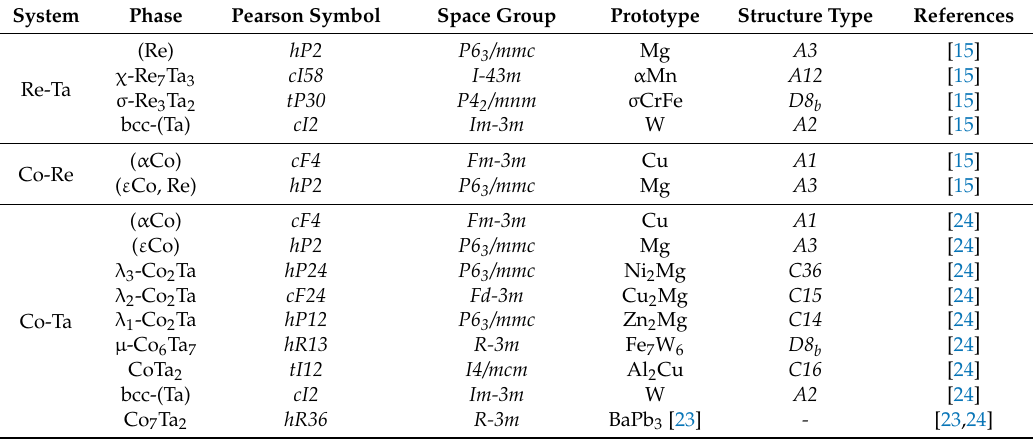
Figure 1. Binary phase diagrams constituting the Co-Re-Ta ternary system [15,24]. Table 1. Crystal structures of each phase in the Co-Re-Ta ternary system [15,23,24].